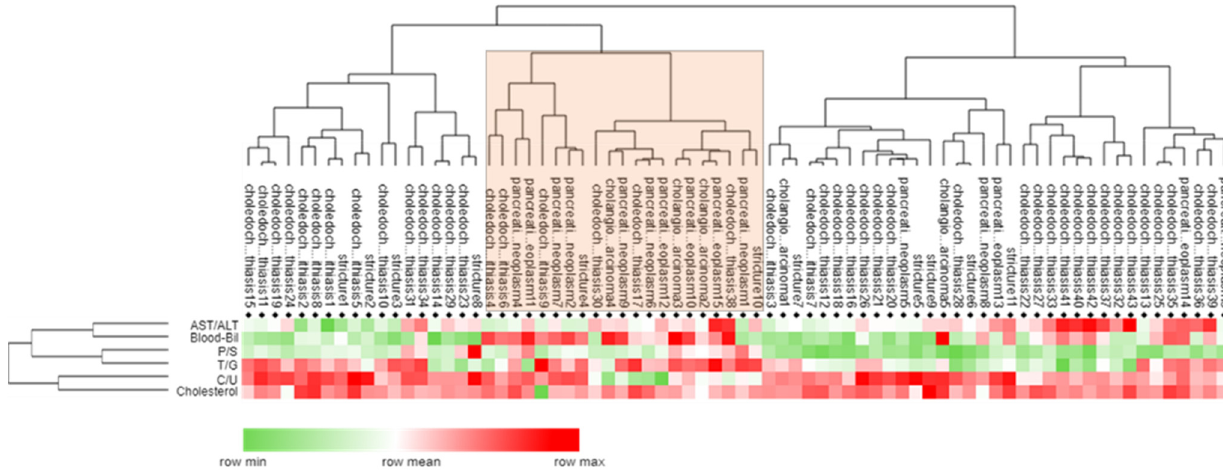
Figure 5. Heatmap and dendrogram of the diagnostic ratios (AST/ALT, conjugated/unconjugated, primary/secondary, taurine/glycine conjugated bile salts), biliary cholesterol, and serum bilirubin in the tested patients with different malignancies. Presence of pancreatic cancer-enriched samples can be identified in the cluster marked with orange (10/15 of pancreatic cancers occur in this cluster).